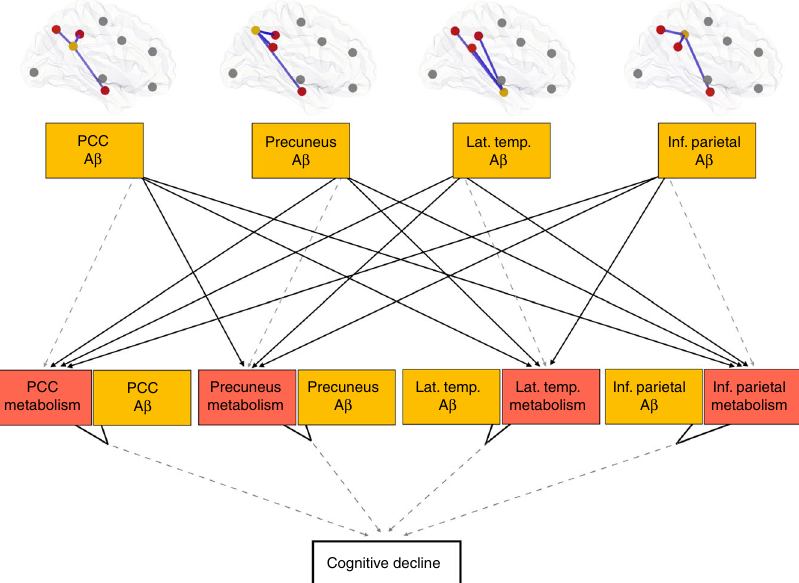
Fig. 7 Structured equation modeling showed that the distant and local amyloid- β (A β ) effects on hypometabolism well describe AD progression. This model represents the hypothesis that distant and local A β effects (yellow) on posterior DMN hypometabolism (red) are associated with cognitive decline. The model used CN A β -positive and MCI A β -positive individuals, and the associations were adjusted for age, gender, education, APOE ε 4 status, p-tau, and gray matter density. Negative associations are shown in solid lines, whereas dashed lines show positive associations. Notably, A β showed positive association with its overlapping metabolism but negative associations with distant metabolism. The hypothesized model fi tted the data well ( n = 223, X 2 = 81, degrees of freedom = 21, P < 0.01, standardized root mean square residual (SRMR) = 0.092, and Comparative Fit Index (CFI) = 0.966)